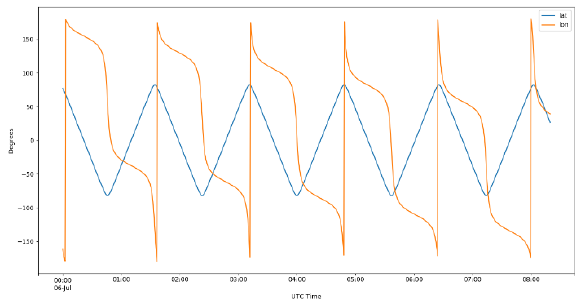
Figure 6: Temporal variations of Latitude and Longitude for Worldview-4.